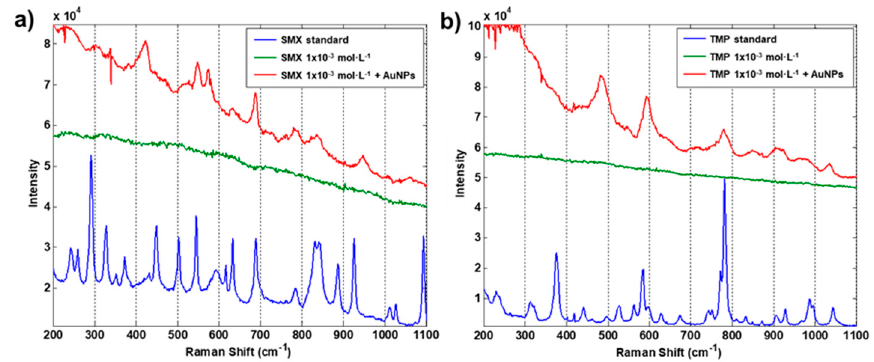
Figure 3. Conventional Raman spectra and SERS of both drugs: ( a ) SMX and ( b ) TMP.